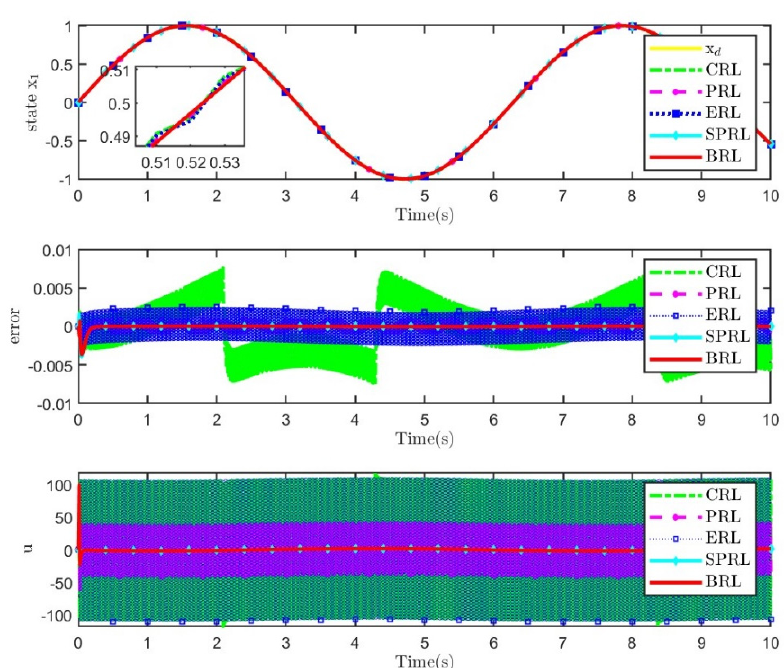
Figure 4. Sliding mode motions for different reaching laws under step signals.